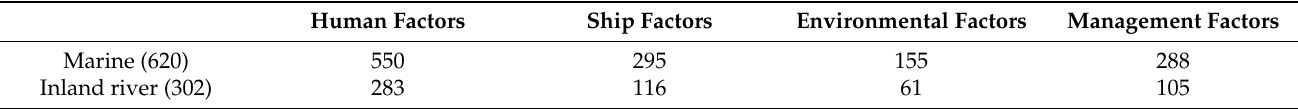
Table 1. Statistic of risk factors of inland river and marine accidents. Human